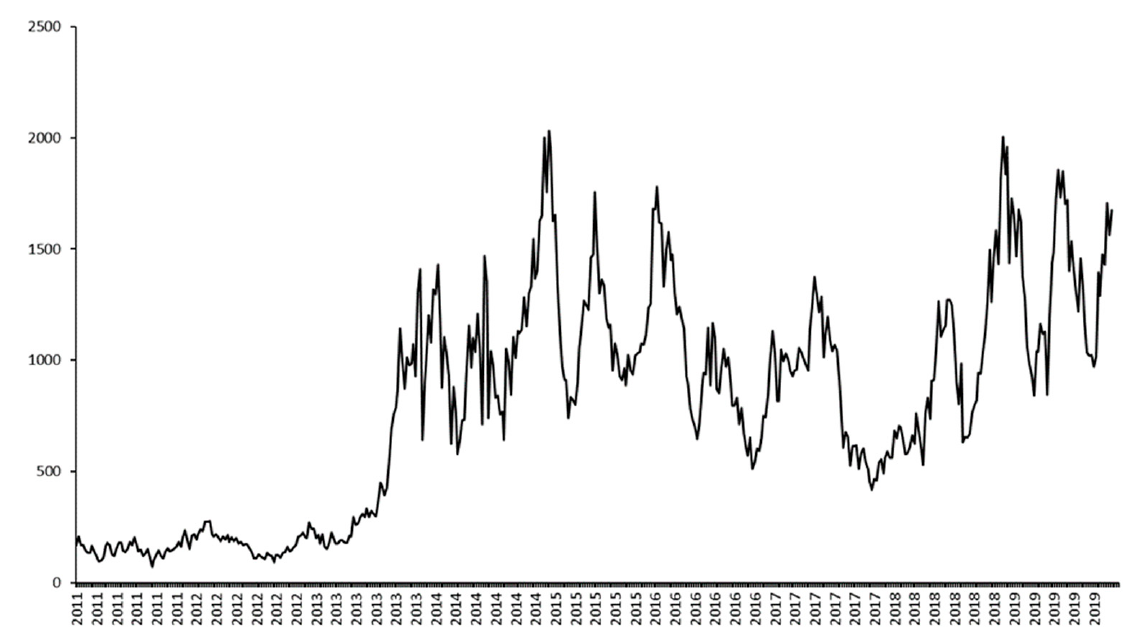
Figure A3. Dengue case in Kelantan, 2011 to 2019.